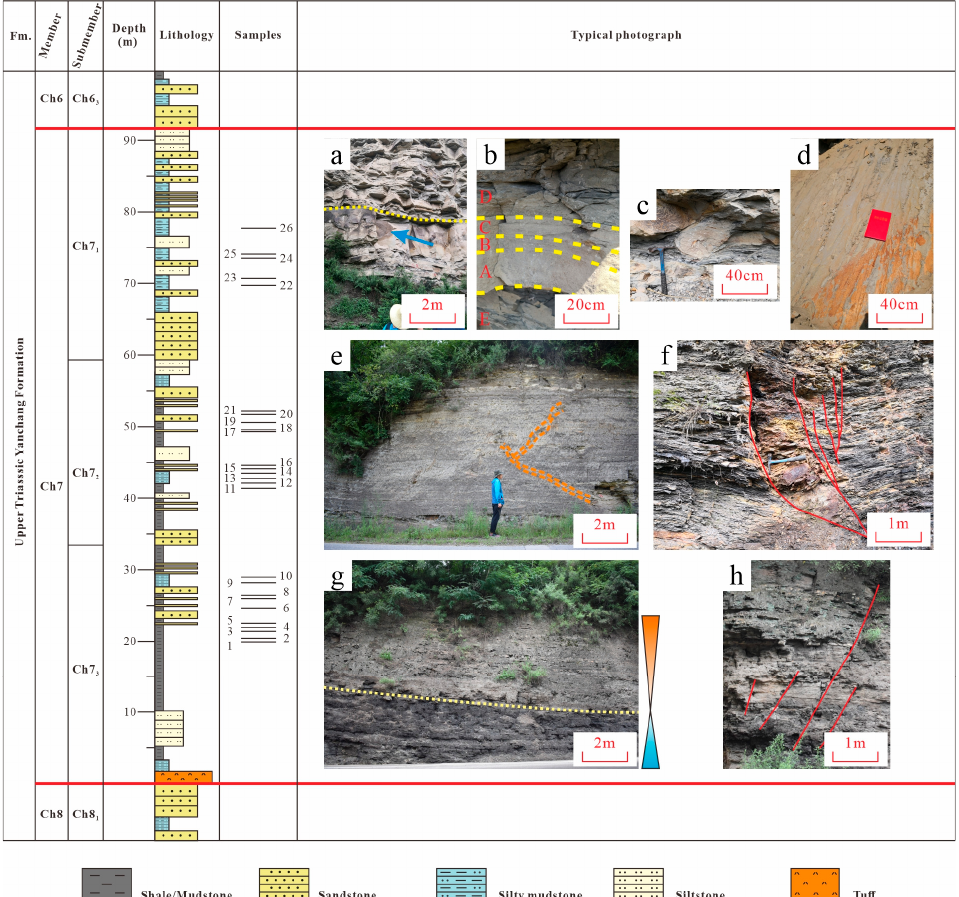
Figure 2. Lithology and typical sedimentary outcrops of the Chang 7 Member in the Ordos Basin. ( a ) Hydrodynamic transformation of Chang 7 1 ; the sedimentary section shows that thick sandy clastic rheology changes into thin low-density turbidity sand body, and the blue arrow in the figure indicates rotating structure; ( b ) Bouma sequence; ( c ) Load construction; ( d ) Groove die; ( e ) The lithology of Chang 7 2 is mainly black shale, and the position circled by orange dotted line in the map is liquefied sandstone vein; ( f ) Brittle deformation; ( g ) The bottom of Chang 7 3 is tuffaceous black shale, and the sand content increases upwards, showing that the lake level rises first and then decreases; ( h ). Stepped fracture.